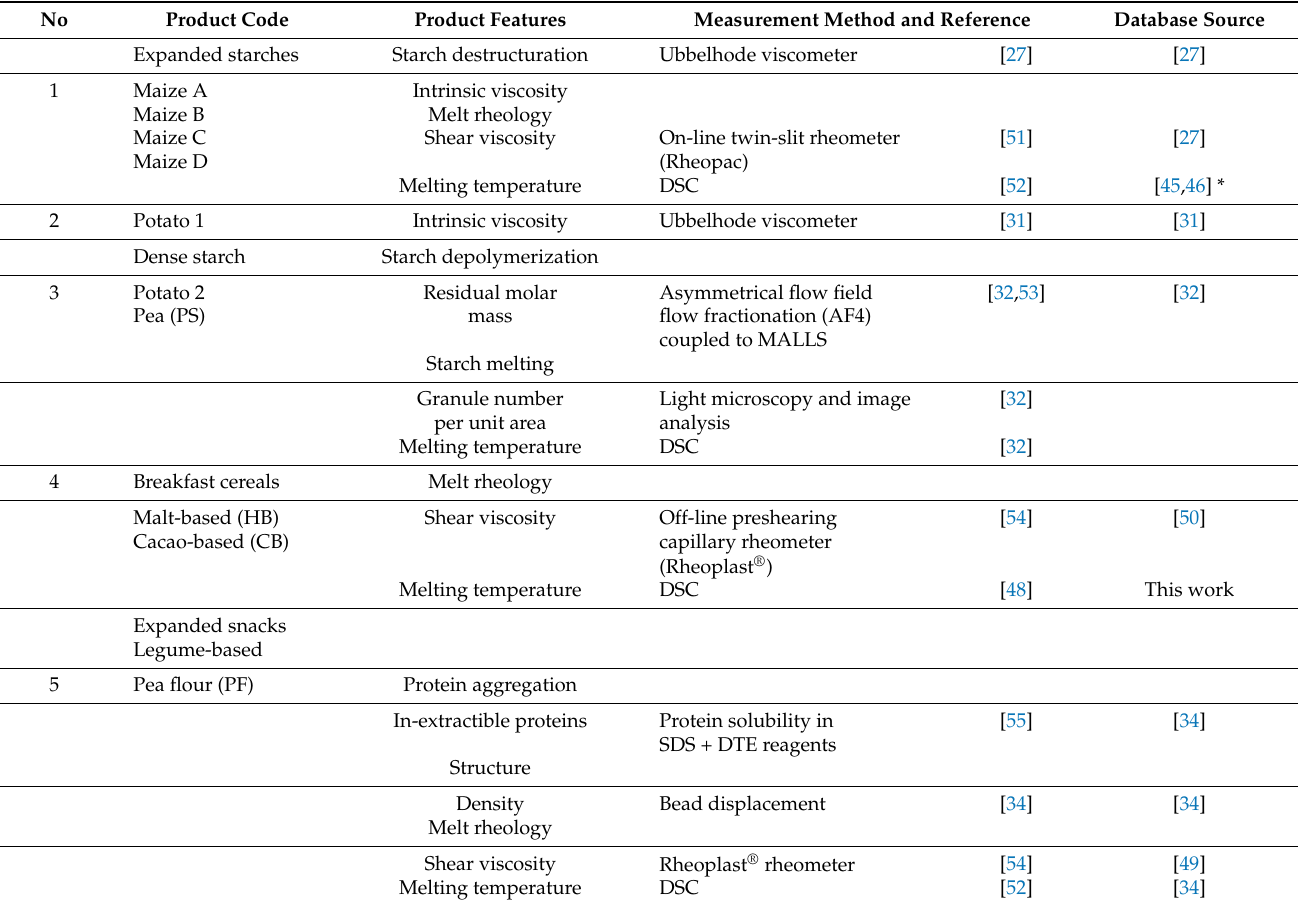
Table 4. Data base of measured structure and properties of extruded